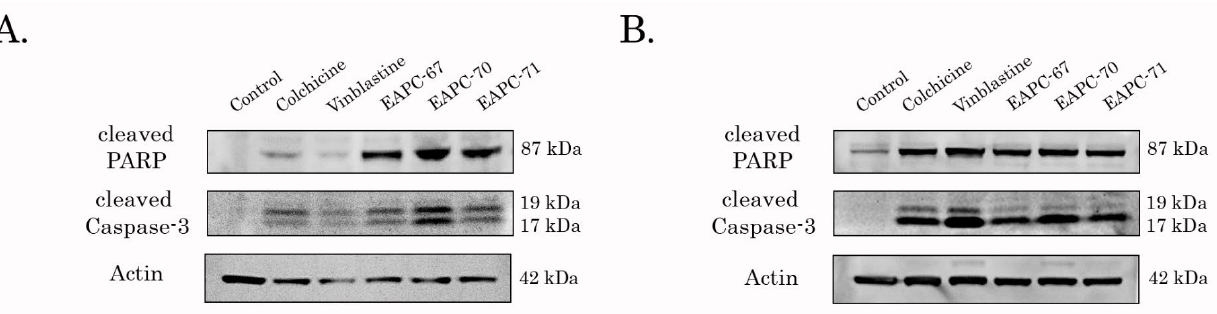
Figure 4. Immunoblot analysis for apoptosis markers (e.g., cleaved forms of PARP and caspase-3) in H1299 lung cancer ( A ) and HCC1806 breast cancer ( B ) after treatment with DMSO (negative control), EAPC-67, EAPC-70, EAPC-71 (10 µ M), colchicine (0.05 µ M) and vinblastine (0.01 µ M) for 24 h. Actin stain is used as a loading